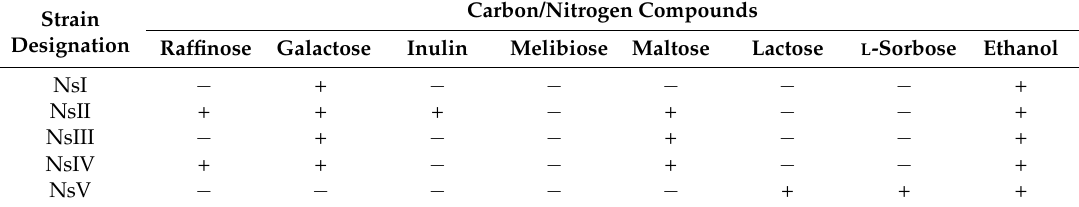
Table 4. Assimilation of different carbon/nitrogen compounds by non- Saccharomyces species, isolated from “Fino” Sherry wine, analyzed with microtiter technology. Values are expressed as (+) if yeast strains were able to assimilate the carbon/nitrogen source and ( − ) if yeast strains were not able to assimilate